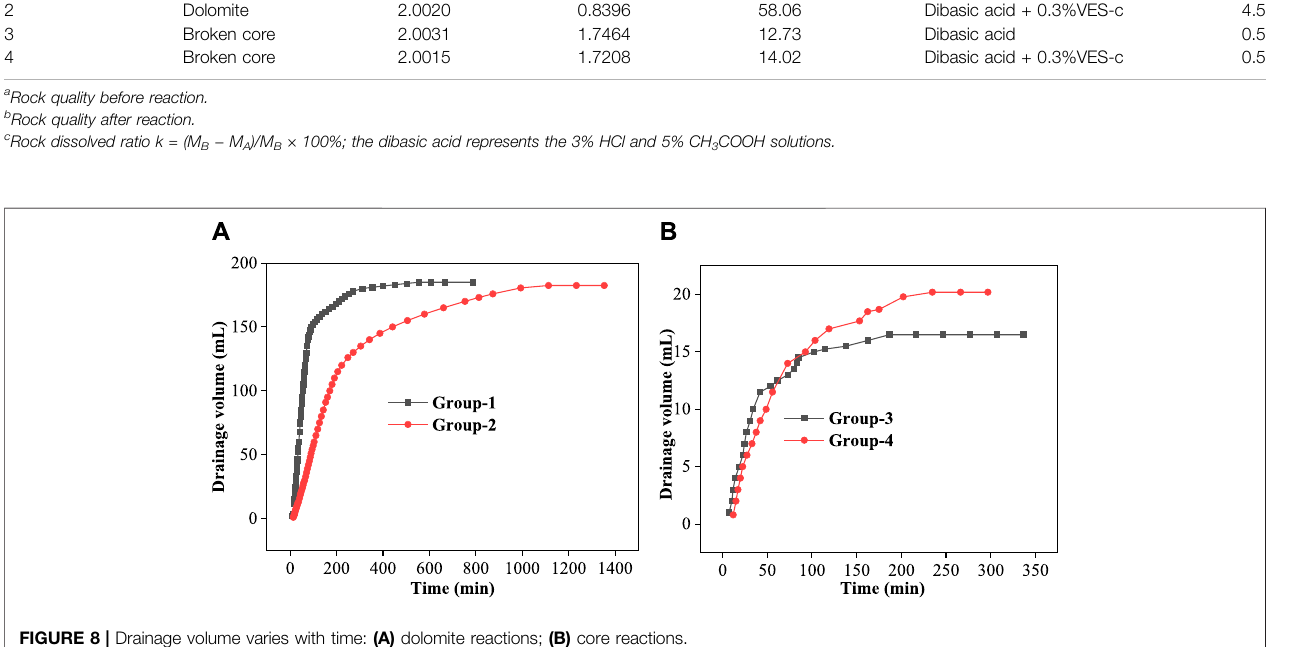
Frontiers in Chemistry |